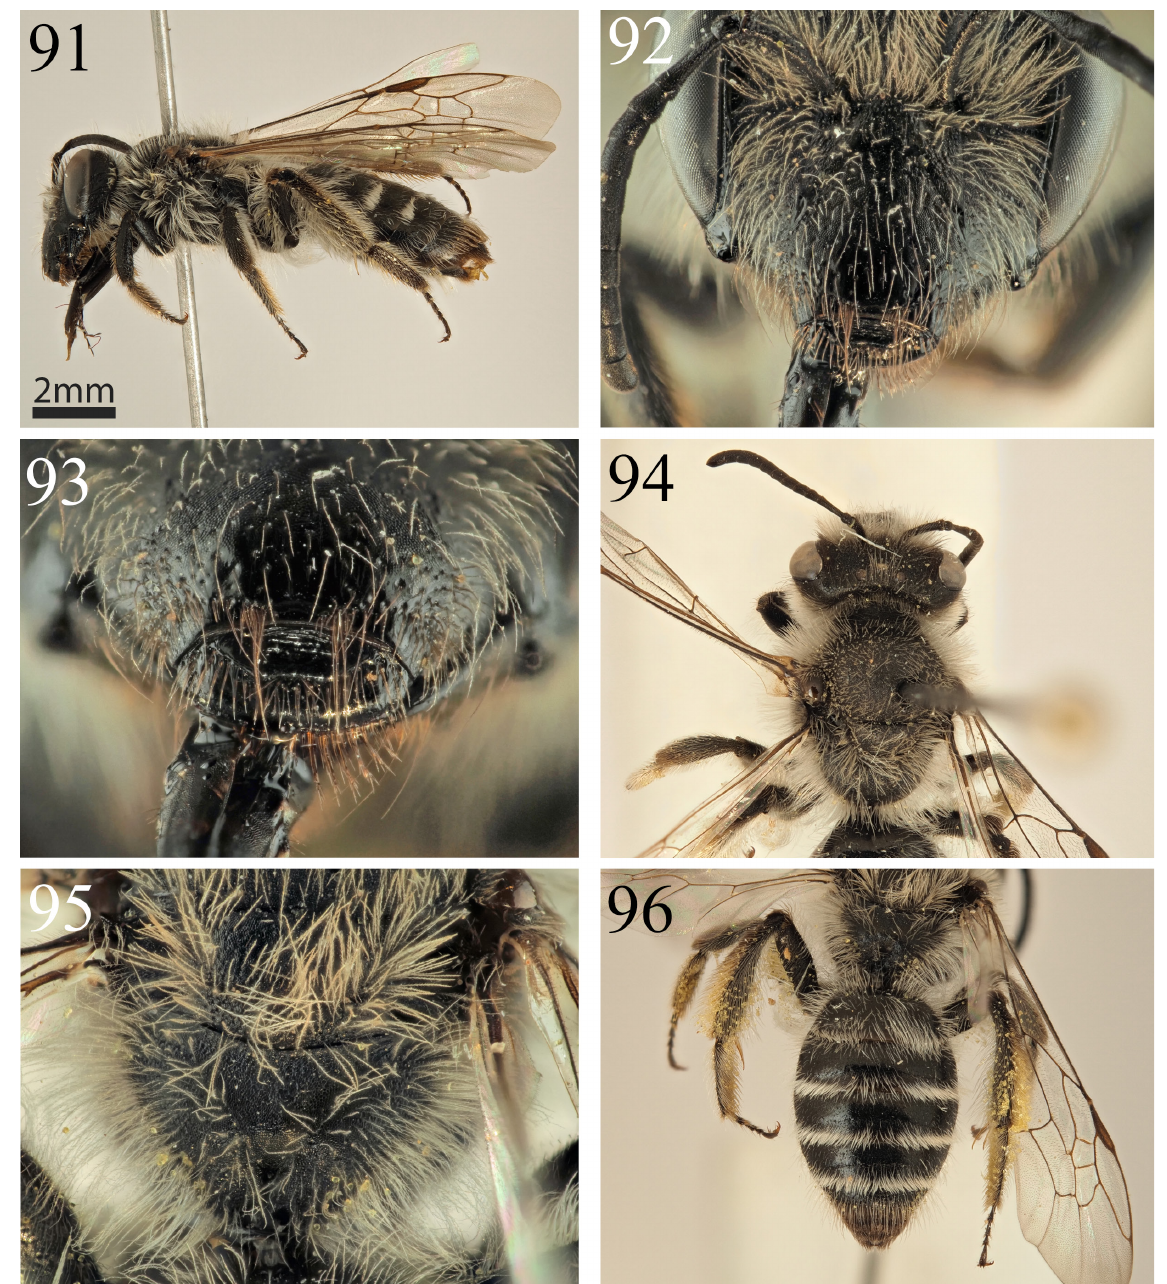
Figs 91–96. Andrena huma sp. nov., ♀ (OÖLM) . 91 . Profile. 92 . Face. 93 . Process of labrum. 94 . Dorsum. 95 . Propodeum. 96 .